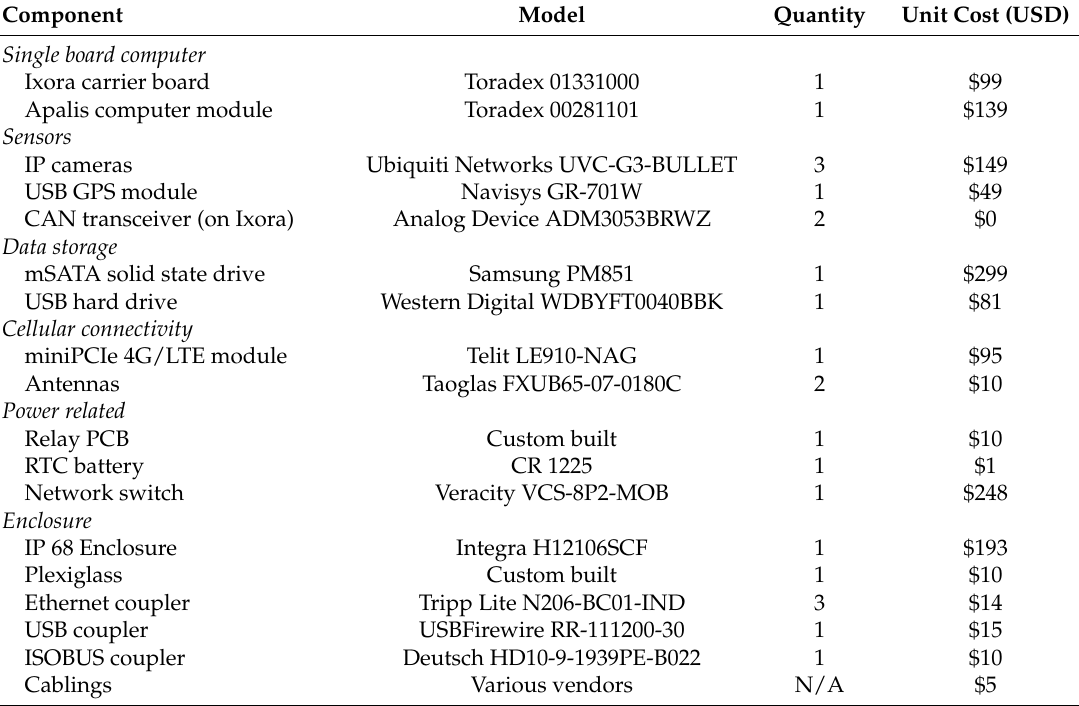
Table A1. Bill of Materials for hardware components utilized in ISOBlue HD